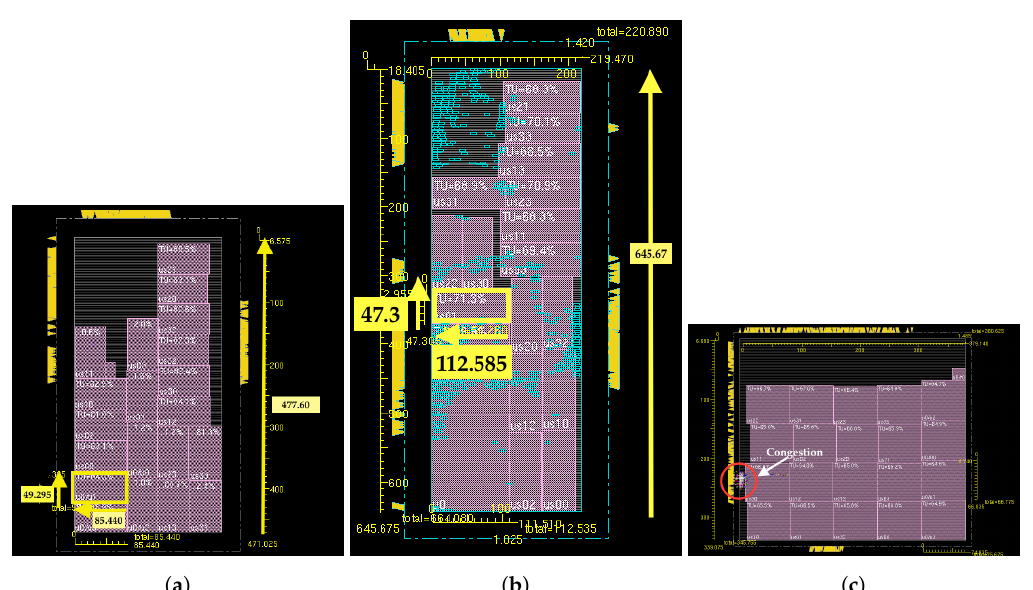
Figure 9. Floorplans of AES _ core after proposed algorithm for aspect ratio 2:1, 3:1, and 1:1. ( a ) 2:1 aspect ratio; ( b ) 3:1 aspect ratio; ( c ) 1:1 aspect ratio.